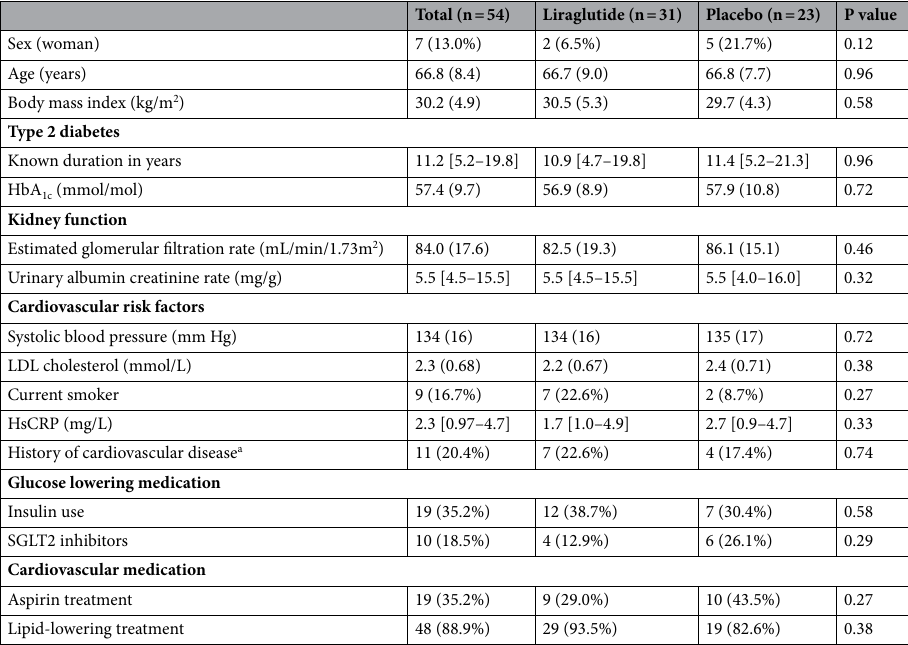
Table 1. Characteristics of the participants at baseline. Data are n (%), mean (SD) or median [IQR]. Differences in baseline characteristics between the liraglutide and the placebo group were tested using un-paired t-test and the χ 2 test. hsCRP high sensitivity C reactive protein, SGLT2 sodium glucose transporter 2. a A history of cardiovascular atherosclerotic disease was defined as a history of acute myocardial infarction, percutaneous coronary intervention, coronary artery bypass graft, stroke, peripheral arterial thrombosis, claudication and/or nitroglycerin requiring angina